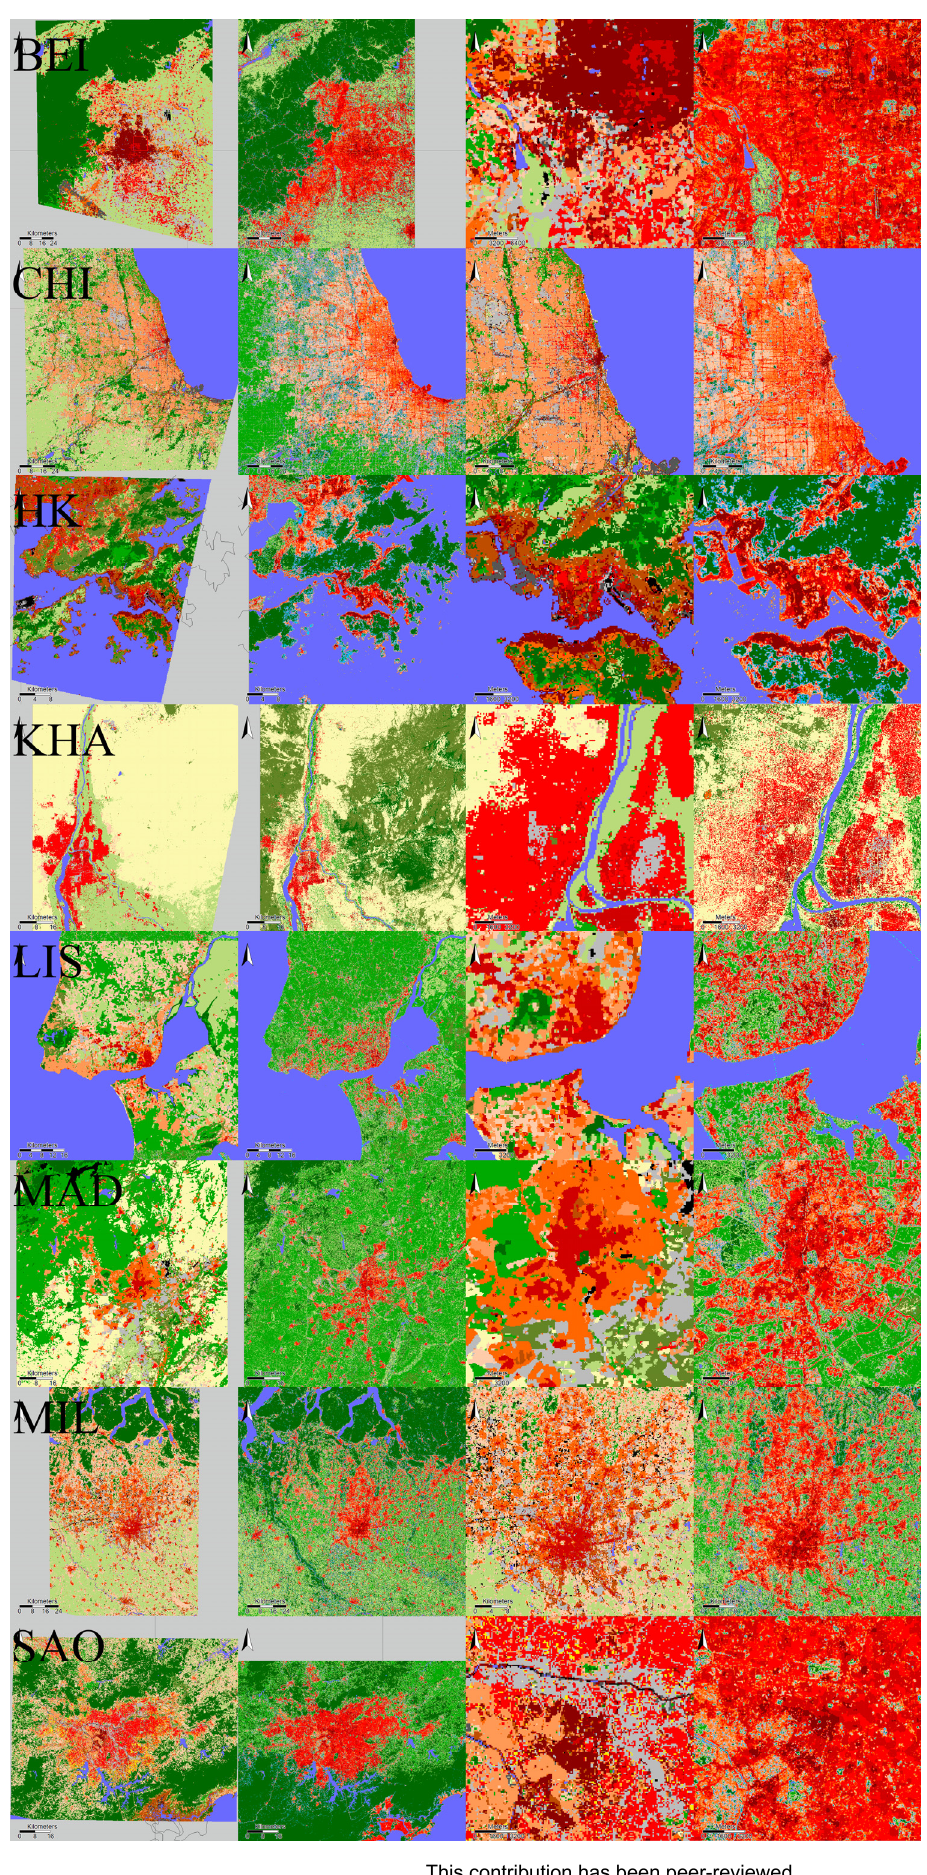
Figure 2. Classifications